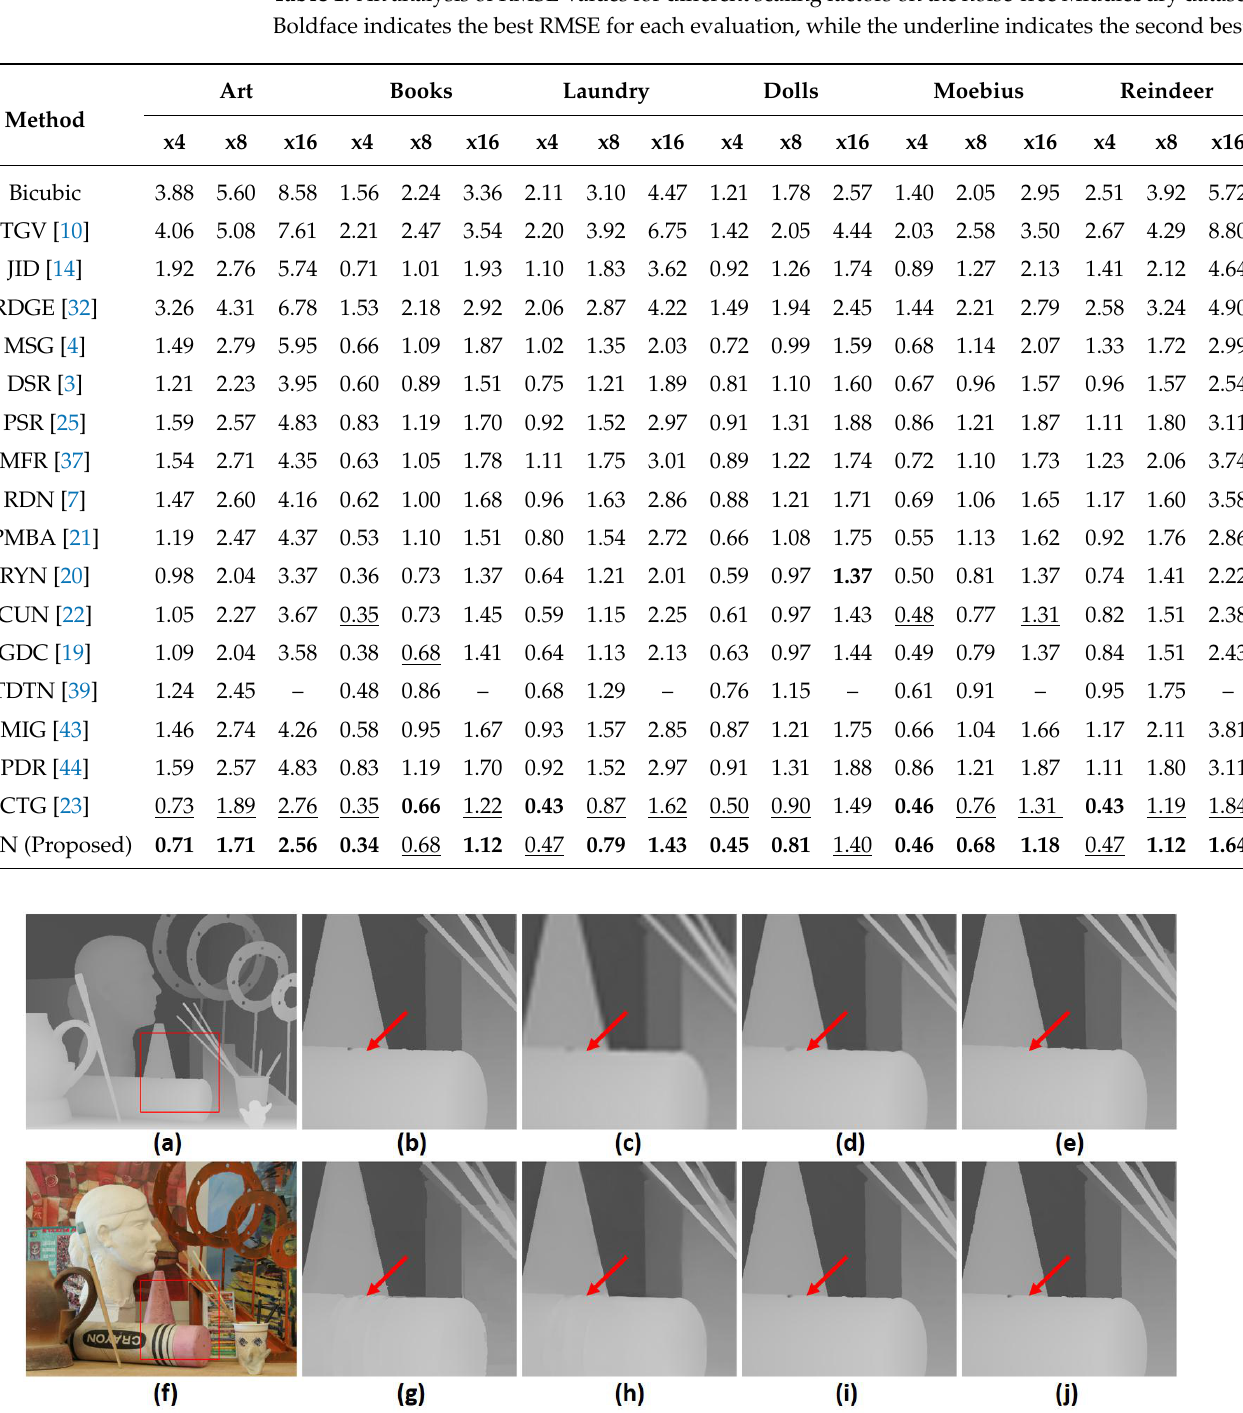
Figure 3. A visual quality comparison for depth map SR at a scale factor of 8 on the noise-free “art” dataset. ( a ) HR depth image, ( f ) HR color image, ( b ) extracted ground truth patch (marked by a red square), and upsampled patches by ( c ) Bicubic, ( d ) MSG [4], ( e ) DSR [3], ( g ) RDGE [32], ( h ) RDN [7], ( i ) CTG [23], ( j ) the proposed FCTN method (best viewed on the enlarged electronic